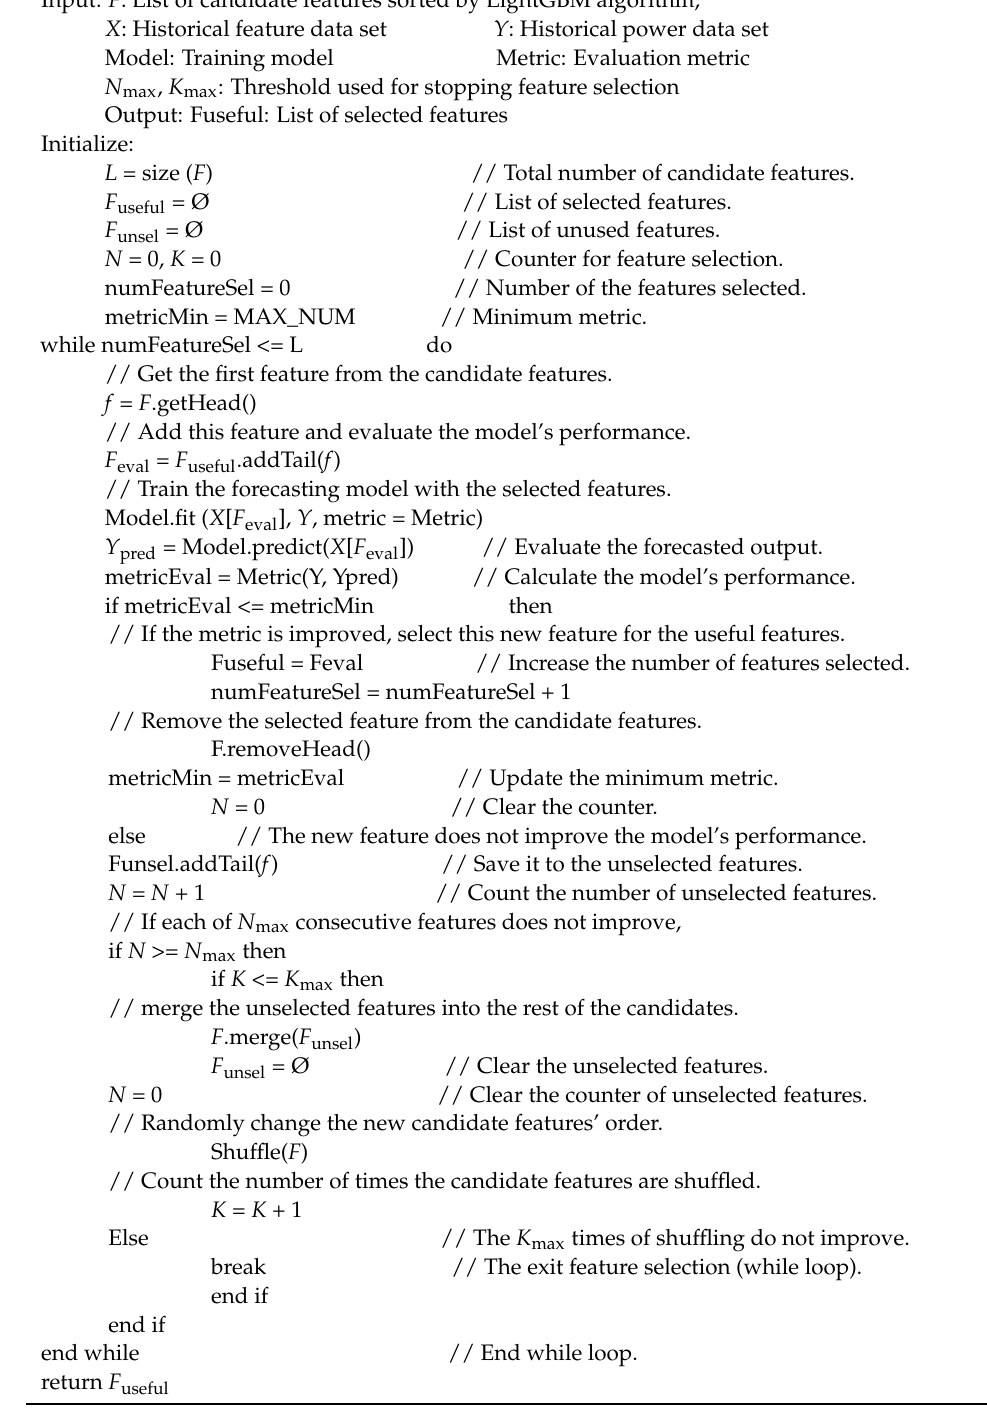
Algorithm 1 : Feature selection in consideration of the feature combination